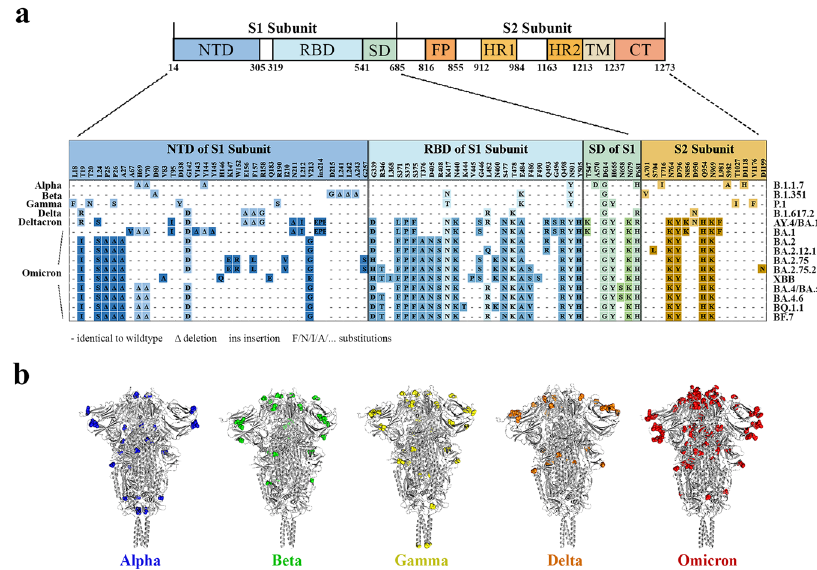
Fig. 2 Composition of SARS-CoV-2 S and alignment of S mutation points of SARS-CoV-2 variants. a S can be proteolytically cleaved into S1 and S2 subunit. The S1 subunit contains the immunodominant N-terminal domain (NTD) and receptor-binding domain (RBD) as well as other subdomains. Fusion peptide (FP), heptad repeat 1 (HR1), heptad repeat 2 (HR2), transmembrane domain (TM), C-terminal peptide (CP) together with other unnamed parts comprise the S2 subunit. Names of the variants are labeled on both sides of the table. Mutation points are distinguished by different colors. Changes in Omicron-related strains are labeled with darker colors. Amino acid sequence of the index virus is included as a reference. At each given point, a hyphen means the amino acid is identical to that of the reference, Δ stands for deletion, ins stands for insertion, and various capital letters indicate substitutions. b Spatial positions of mutations in Alpha, Beta, Gamma, Delta, and Omicron variants are highlighted in structure models (PDB